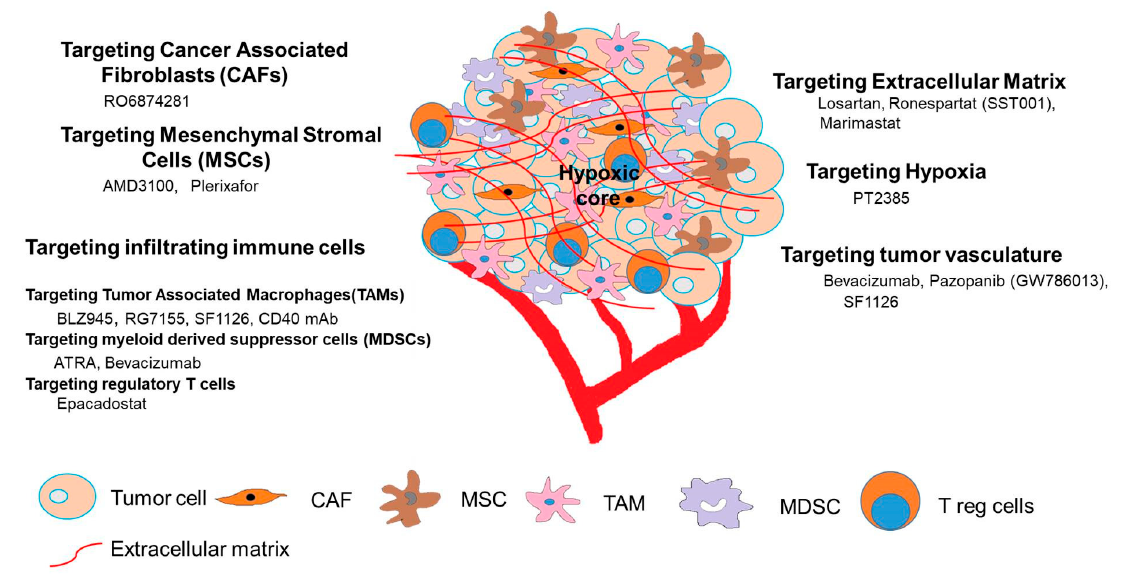
Figure 1. Strategies used to target tumor microenvironment in neuroblastoma.